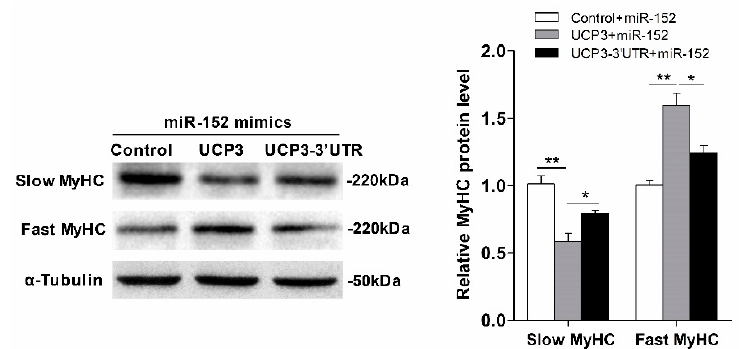
Figure 7. UCP3 mediates miR-152 action in slow-twitch myofiber formation. Protein expression of slow / fast MyHC in porcine myotubes co-transfected with miR-152 or / and UCP3 overexpression plasmid with or without the 3 ′ UTR. α -Tubulin served as an internal control. Results are exhibited as mean ± S.E.M. ( n = 4, four independent experiments). * p < 0.05 and ** p < 0.01 when contrasted with the control.